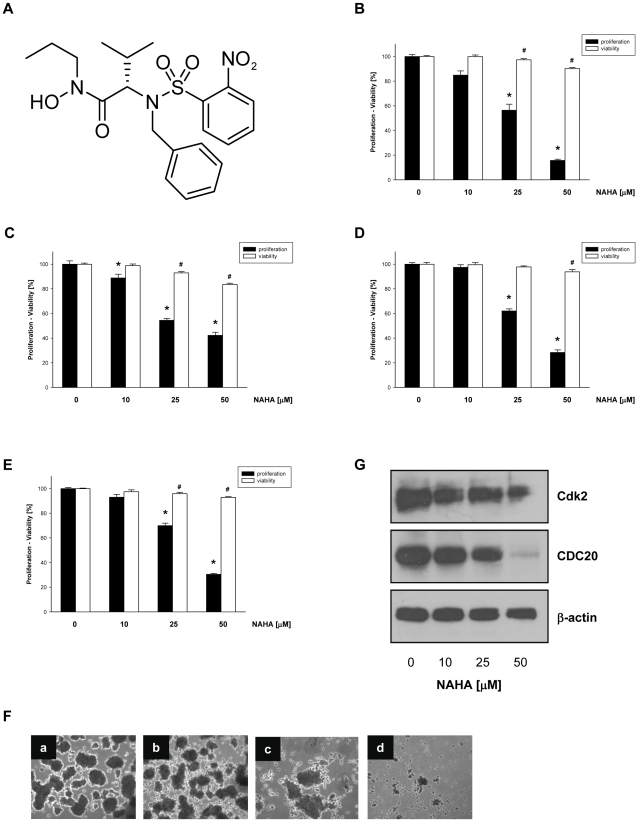
NAHA inhibits growth of breast cancer cells.(A) Structure of NAHA, 2-[Benzyl-(2-nitro-benzenesulfonyl)-amino]-N-hydroxy-3-methyl-N-propyl-butyramide. (B) MDA-MB-231, (C) MCF-7, (D) MCF-10A, (E) HMEC cells were treated with NAHA (0–50 µM). Cell proliferation was determined by the tetrazolium salt method as described in
Materials and Methods
. Cell viability was determined by trypan blue staining as described in
Materials and Methods
. Data are the means ± SD. Similar results were obtained in at least two additional experiments. * p<0.05 for cell proliferation, # p<0.05 for cell viability. (F) Anchorage-independent growth (colony formation) of MDA-MB-231 cells was assessed on 1% agarose after incubation with NAHA (a – 0, b – 10 µM, c -25 µM, d – 50 µM) for 14 days as described in
Materials and Methods
. (G) MDA-MB-231 cells were treated with NAHA (0–50 µM) for 24 hours and whole cell extracts were subjected to Western blot analysis with anti-Cdk2 and anti-CDC20 antibodies as described in
Materials and Methods
. The equal protein loading was verified with anti β-actin antibodies. The rfesults are representative of three independent experiments.